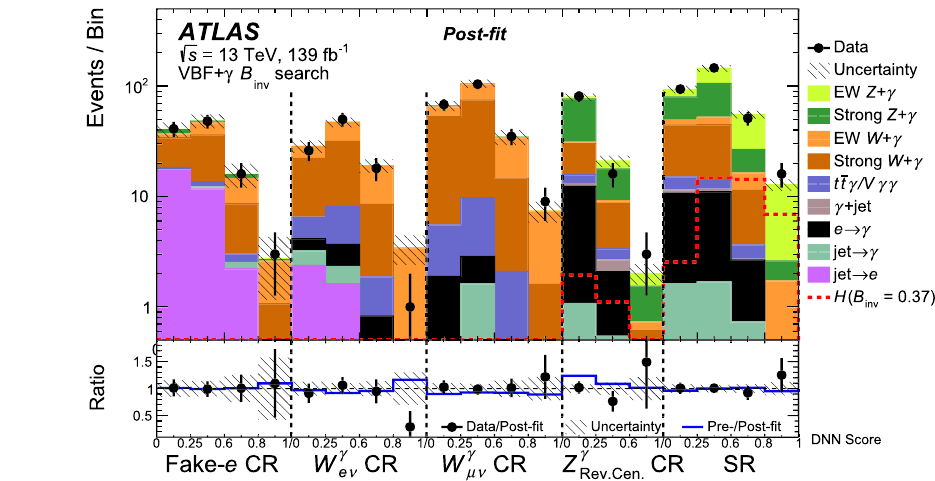
Table 8 Data yields and background predictions, after the fit to 139fb − 1 of data with the B inv signal normalization set to zero, for the four DNN output score bins of the SR and the inclusive CRs. The uncertainties in the backgrounds are derived by the fit and include the effects of nuisance parameter constraints and the correlation of system-